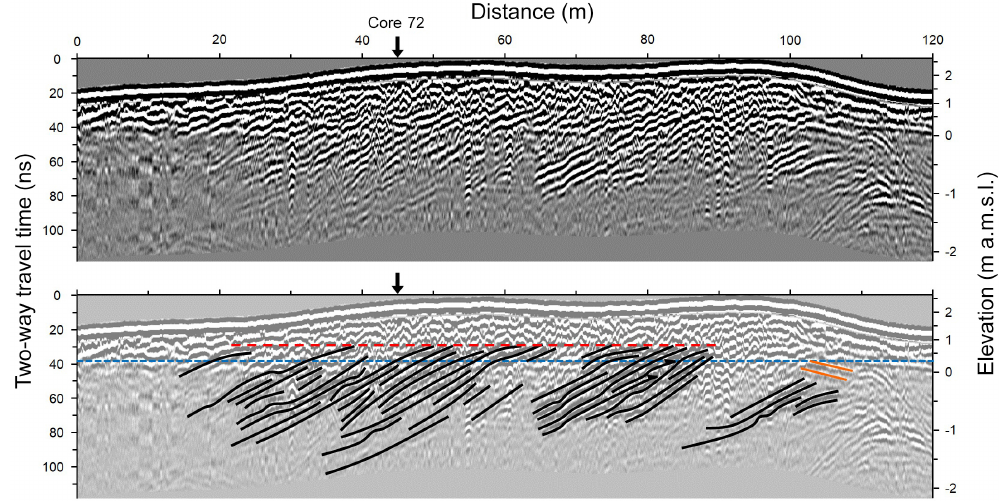
Figure 8. Processed GPR data and interpretation for two closely spaced relatively elevated beach ridges along Transect A (see Figs. 2a and 3a for location). Time-to-depth conversion for the elevation axis was based on velocities of 0.125 and 0.06mns − 1 above and below the water table, respectively. The position of the water table at 0.2ma . m . s . l . (blue dashed line) was drawn on the basis of changes in reflection characteristics and confirmed by observations from core 72 (black arrow). Here, the water table was positioned at 2.2m below the land surface. Highlighted in the interpretation are foreshore and shoreface deposits (black dipping lines) and the transition from foreshore to backshore and/or aeolian deposits at 0.8ma . m . s . l . (red dashed line). Also shown are reflection terminations (black half arrows) indicating possible bar welding and some landward-dipping structures (orange lines) possibly related to infill of a large former runnel. The curved reflections around 110m (40ns and deeper) are caused by surface scattering off a large nearby tree that was passed while moving the GPR along the